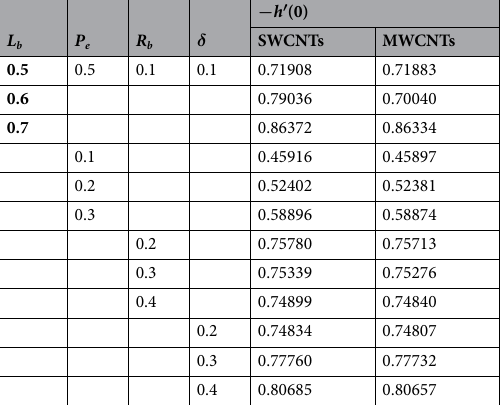
Table 6. Values of Motile density number − Nn Ra